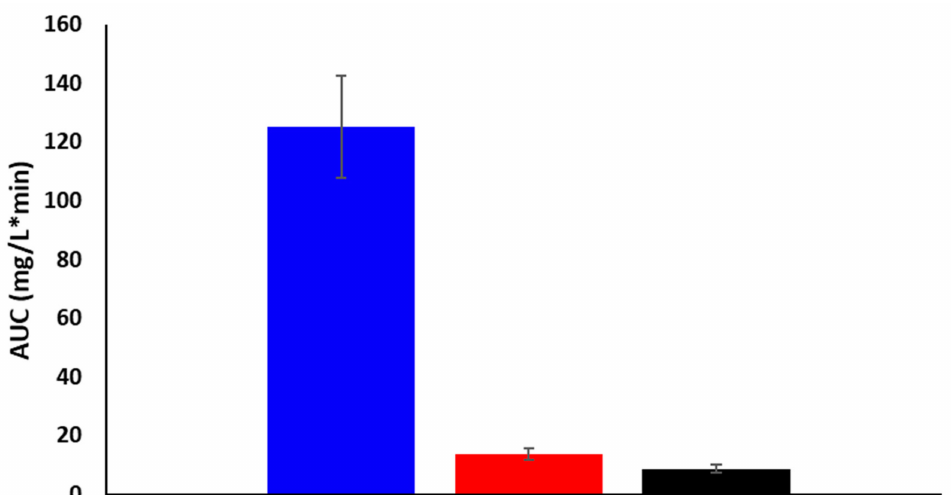
Figure 7. Plasma AUC values of powders and IV formulation.